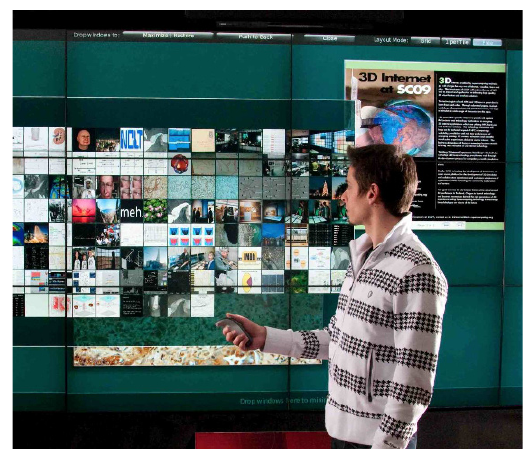
Figure 29. SAGEGyromousecontrolleratEVL.Photo: LanceLong.